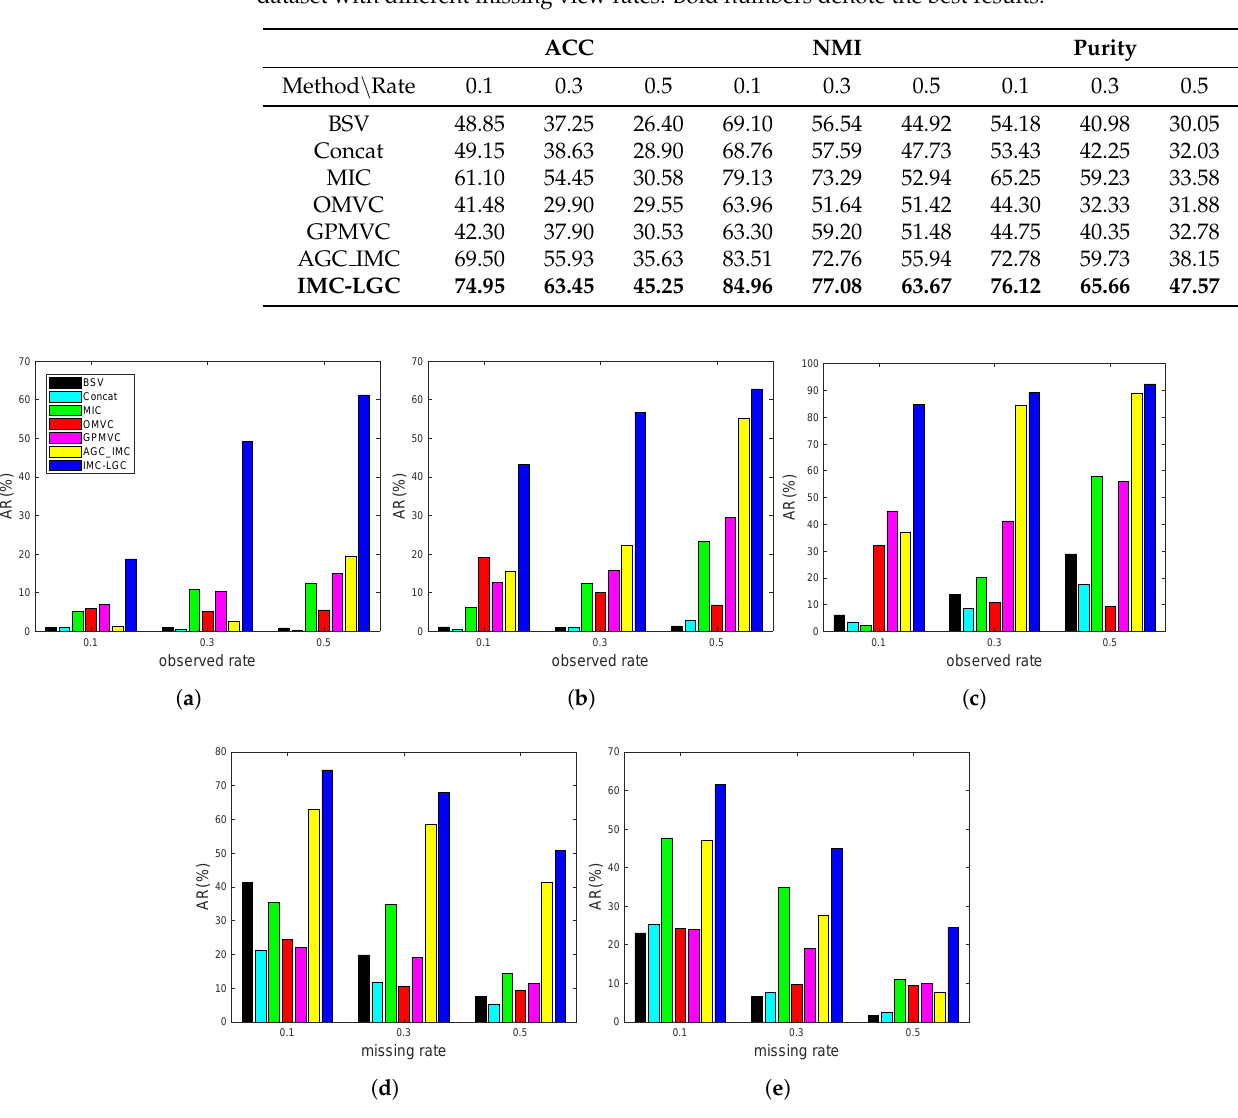
Figure 2. ARs (%) of different methods on the ( a ) BBCSport dataset, ( b ) 3 sources dataset, ( c ) Hand- written dataset with different observed rates of paired samples and on ( d ) MSRC-v1 dataset, ( e ) ORL dataset with different missing view